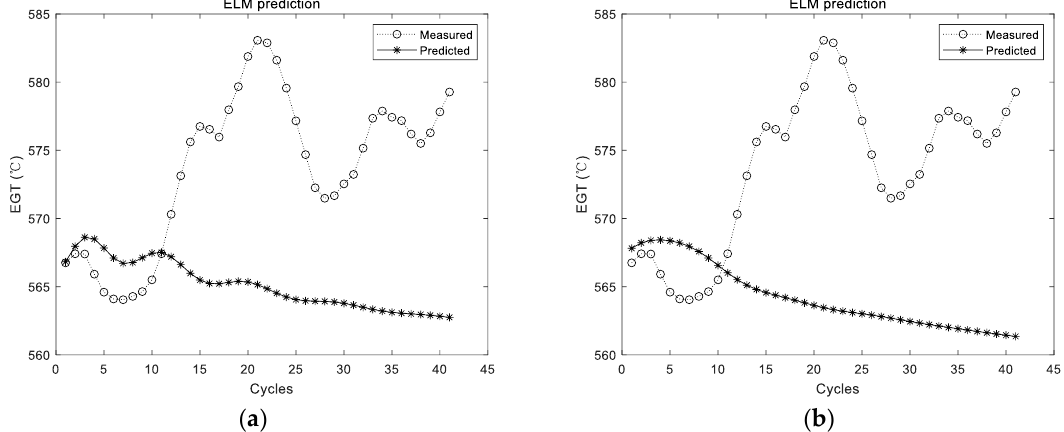
Figure 7. Experimental results of ELM prediction using the second group of data. ( a ) The first experimental results; ( b ) the second experimental results.